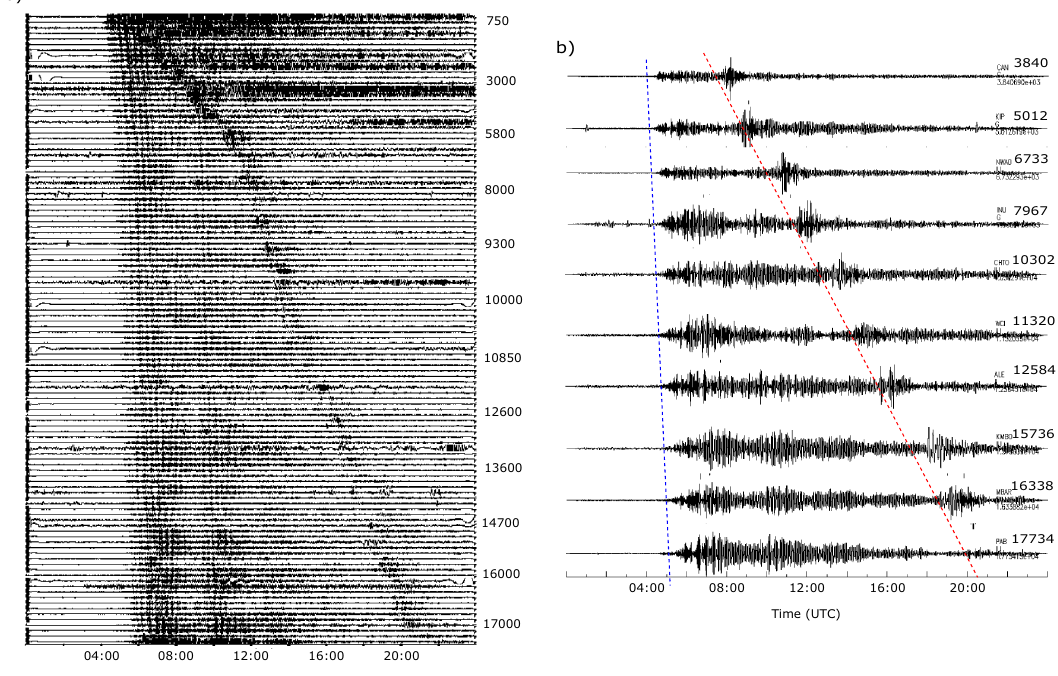
Fig. 5 Low-frequency and atmospheric Lamb wave arrivals around the world. a Seismic traces for the entire dataset fi ltered between 2.5 and 6.5 mHz. The instrument response has been removed and the traces are not normalized in amplitude. Labels show the distance to the Hunga-Tonga volcano (in km). b Selected traces at different distance ranges, fi ltered in the same frequency band. Blue dashed line marks the onset of the low-frequency signal and red dashed lines mark the arrival of the atmospheric Lamb waves.